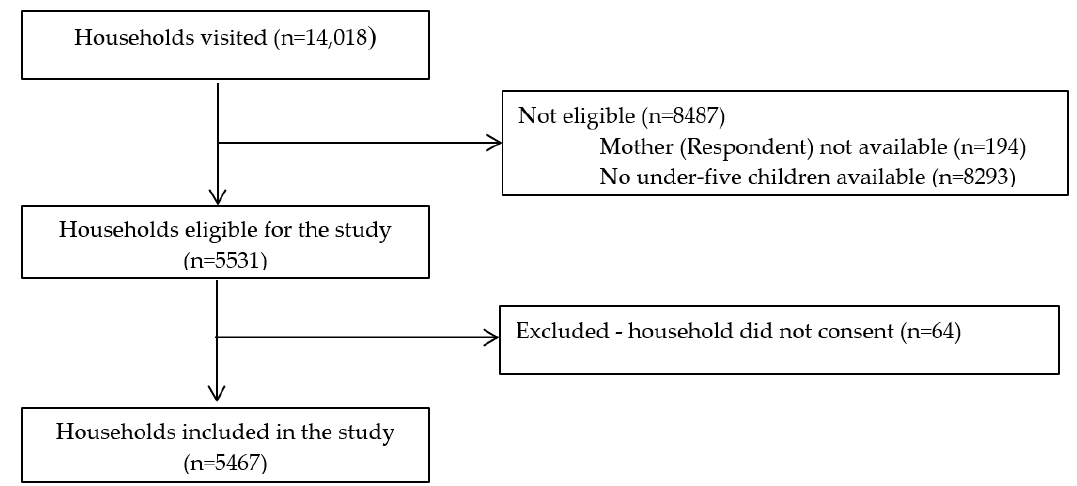
Figure 1. Participant flowchart of households included in the study, Addis Ababa, Ethiopia.